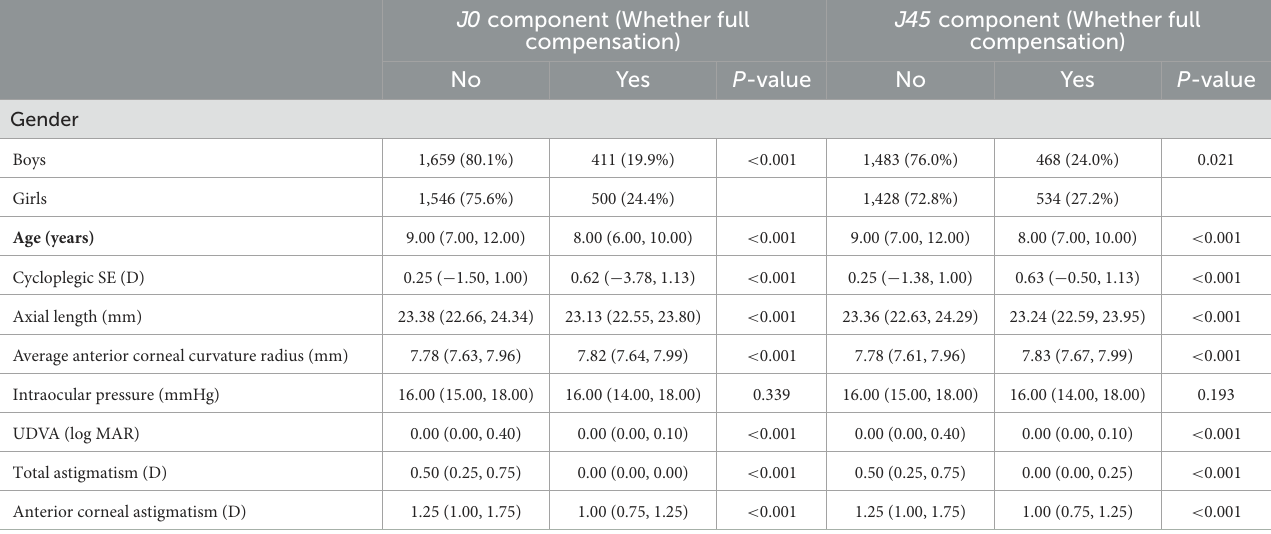
TABLE 2 Comparison of eye parameters for whether full compensation.